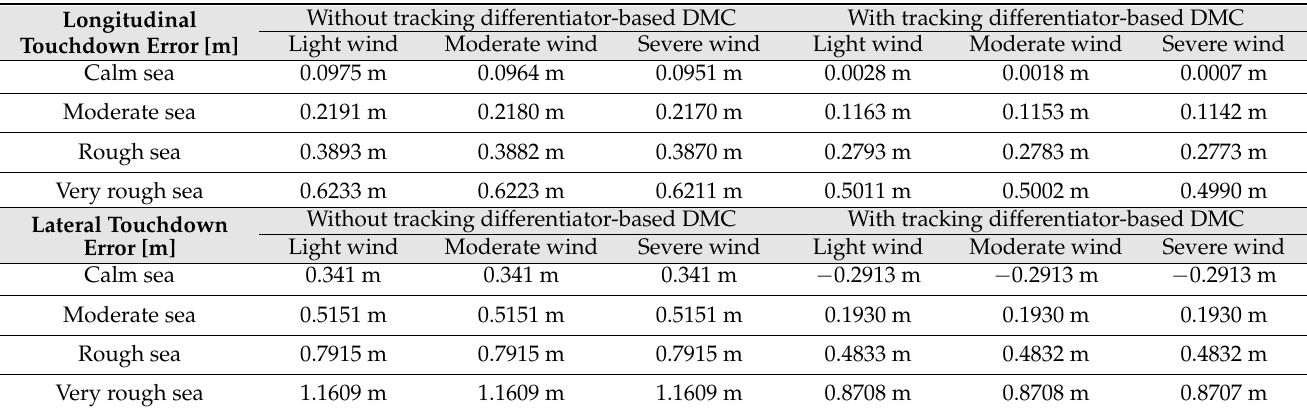
Table 1. Distribution of the touchdown